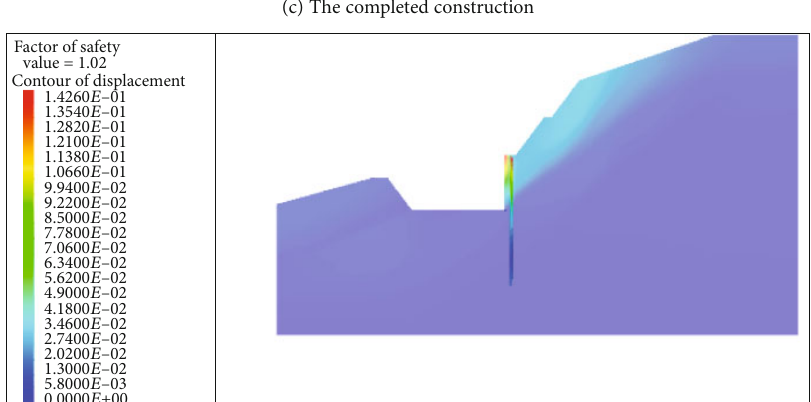
Figure 11: The displacement simulated from the actual construction